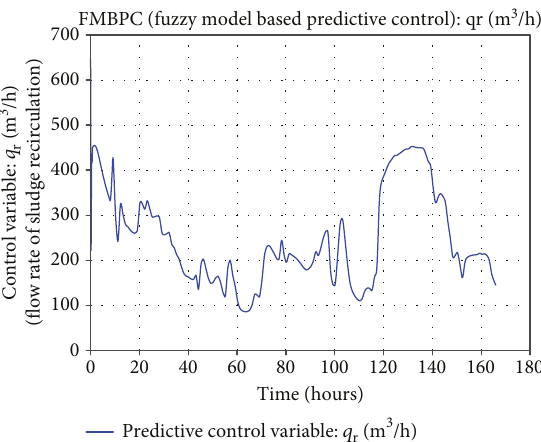
Figure 18: Activated sludge recirculation fl ow rate: the calculated predictive control variable (case